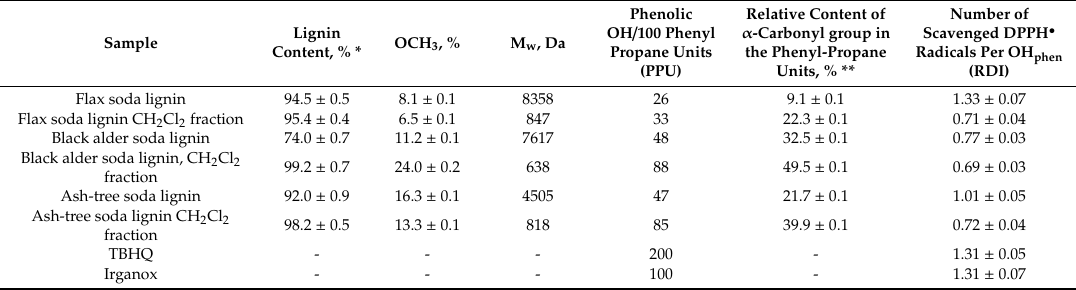
* based on the results of Py-GC / MS analysis of lignin-derived and carbohydrate-derived products. ** Relative content (%) of structures containing α -carbonyl groups in all lignin-derived products, according to results of the Py-GC / MS analysis.